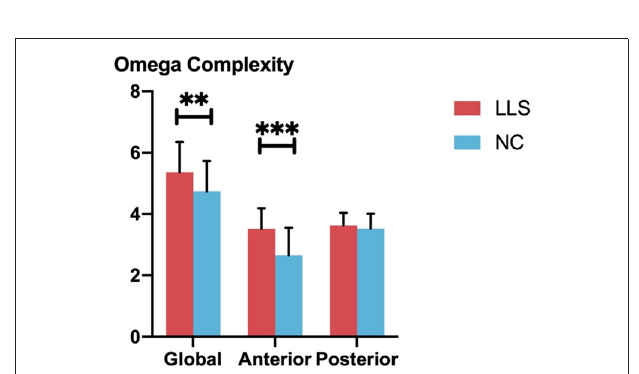
FIGURE 4 | Comparison of global and regional omega complexity between patients with late-life schizophrenia (LLS) and normal controls (NCs). Red bars indicate the omega complexities of patients with LLS, and blue bars indicate the omega complexity of NCs. From left to right, three pairs of bars indicate global omega complexity, anterior complexity, and posterior complexity for each group, respectively. Standard deviations are indicated using the error bar. **indicates p- value ≤ 0.01, ***indicates p -value ≤